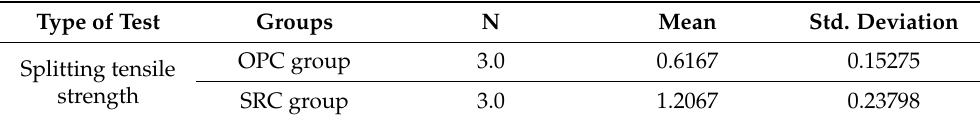
Table 14. Group statistics for splitting tensile strength test after 14